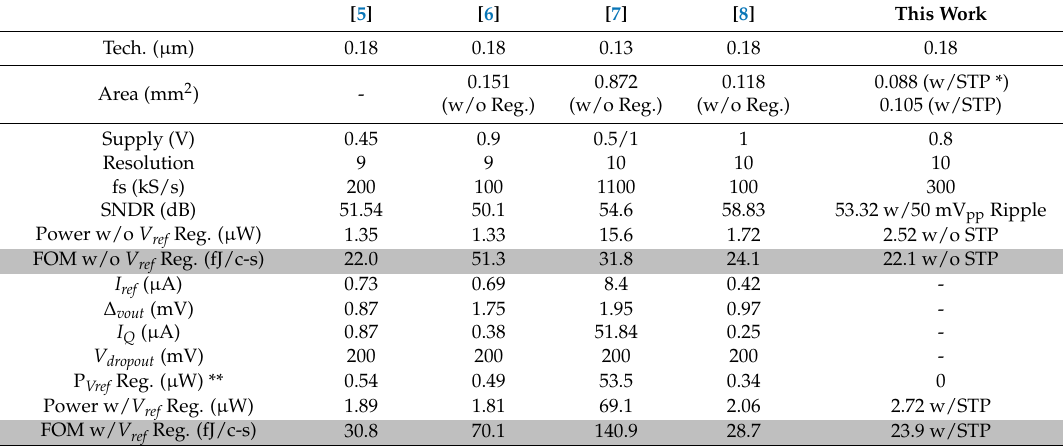
Table 1. Performance